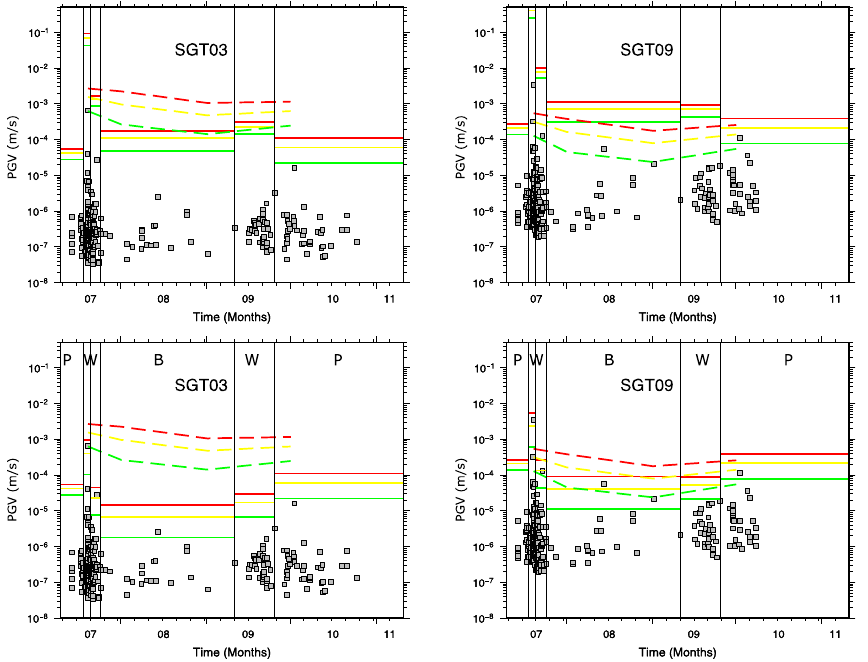
panels indicate the best PDF for each period (P: Poisson; W: Weibull; B: Brownian Passage Time) (See Table 1). Grey squares represent the observed PGVs at the two stations indicated in the two panels .